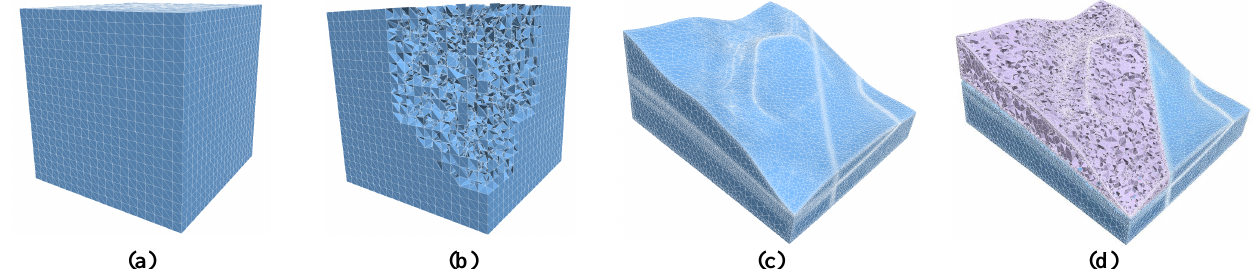
Figure 8. Two experimental models. ( a ) The entire mesh model with 59k nodes; ( b ) The partial mesh model with 59k nodes; ( c ) The entire mesh model with 77k nodes; ( d ) The partial mesh model with 77k nodes.